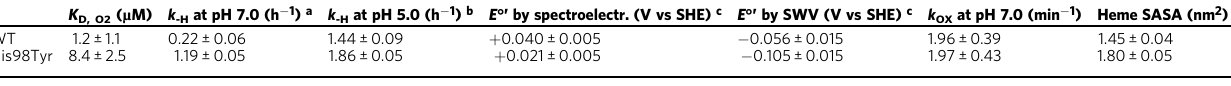
Table 2 Effect of mutation on biochemical properties of